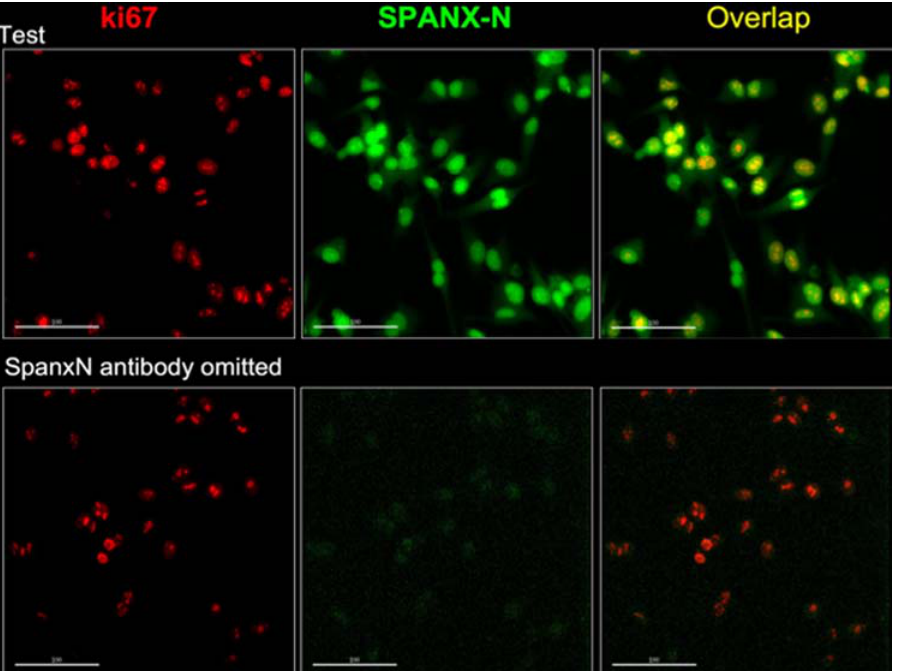
Figure 7. Immunocytochemical detection of SPANX-N in the melanoma cell line. 938MEL melanoma cell line (green; middle and right panels); co- immunostaining for the cell multiplication marker Ki67 (red; left and right panels; overlap with SPANX-N appears as yellow). Upper panels show the test samples, whereas bottom panels provide the negative control for SPANX-N (primary antibody omitted).